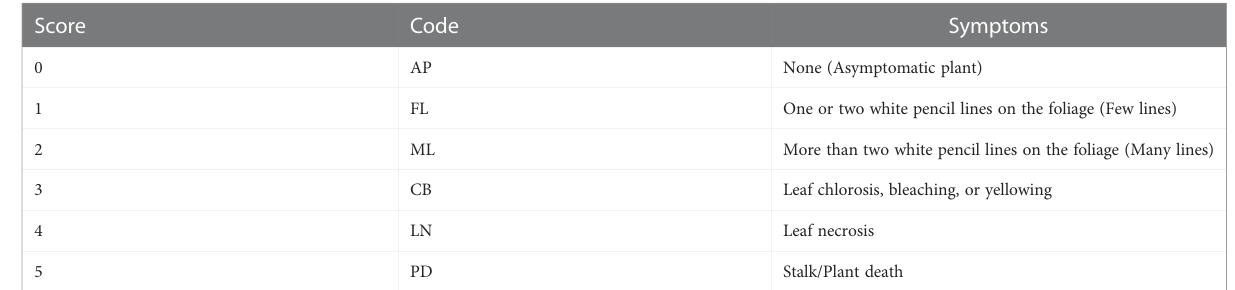
TABLE 1 Rating of leaf scald symptoms on a sugarcane